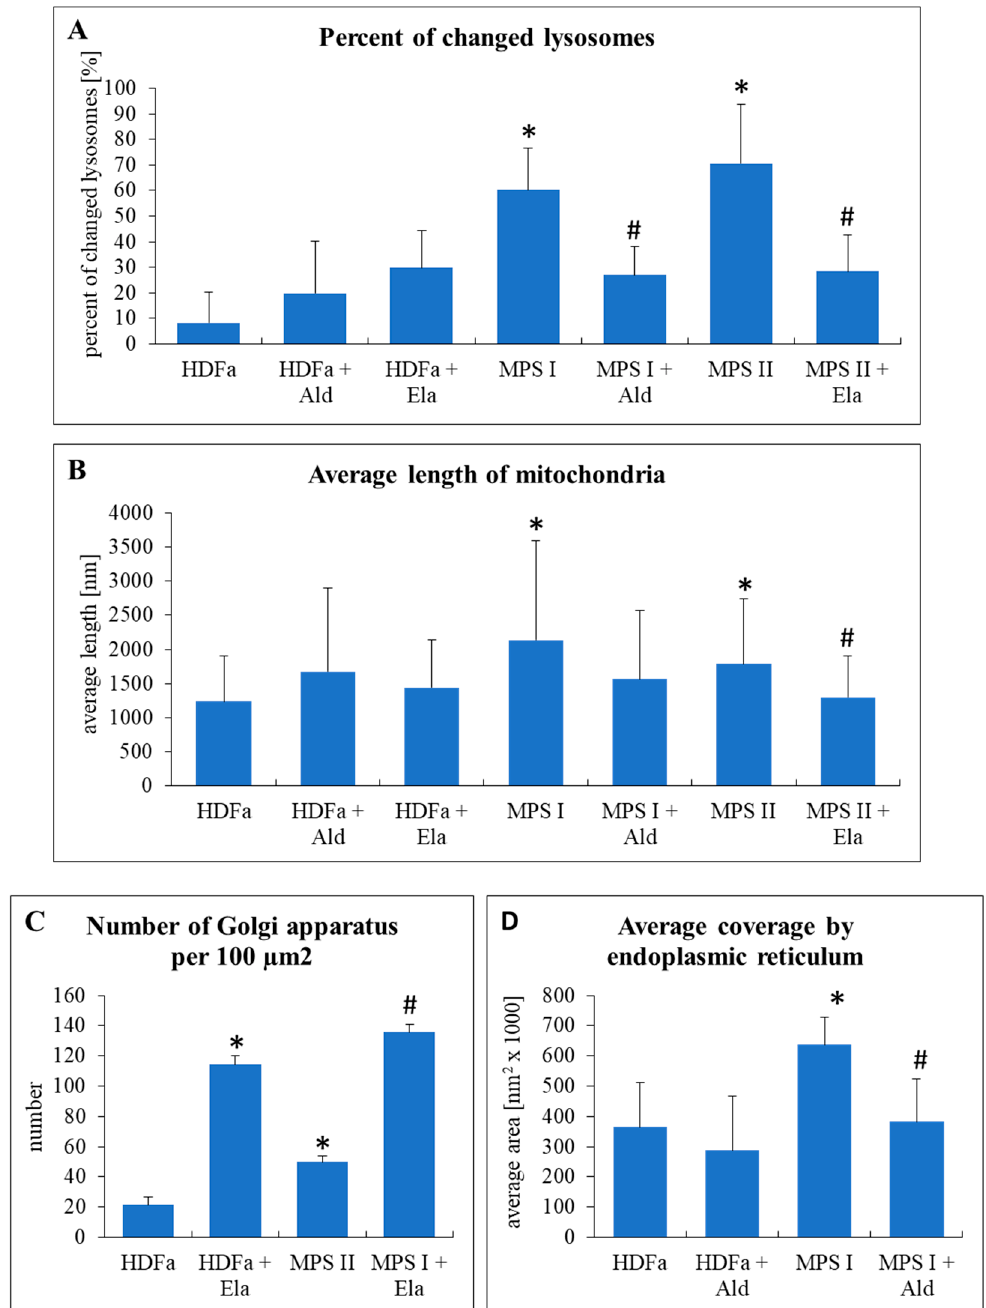
Figure 11. Morphology of lysosomes ( A ), mitochondria ( B ), Golgi apparatus ( C ), and endoplasmic reticulum ( D ) in MPS fibroblasts in comparison to control cells (HDFa cell line) with and without treatment with 0.58 mg/L α -L-iduronidase (Aldurazyme, Ald) or 0.5 mg/L iduronate sulfatase (Elaprase, Ela) for 24 h. Mean values ± SD are presented, with asterisks and hashtags representing statistically significant ( p < 0.05) differences relative to the HDFa control and untreated MPS, re- spectively.